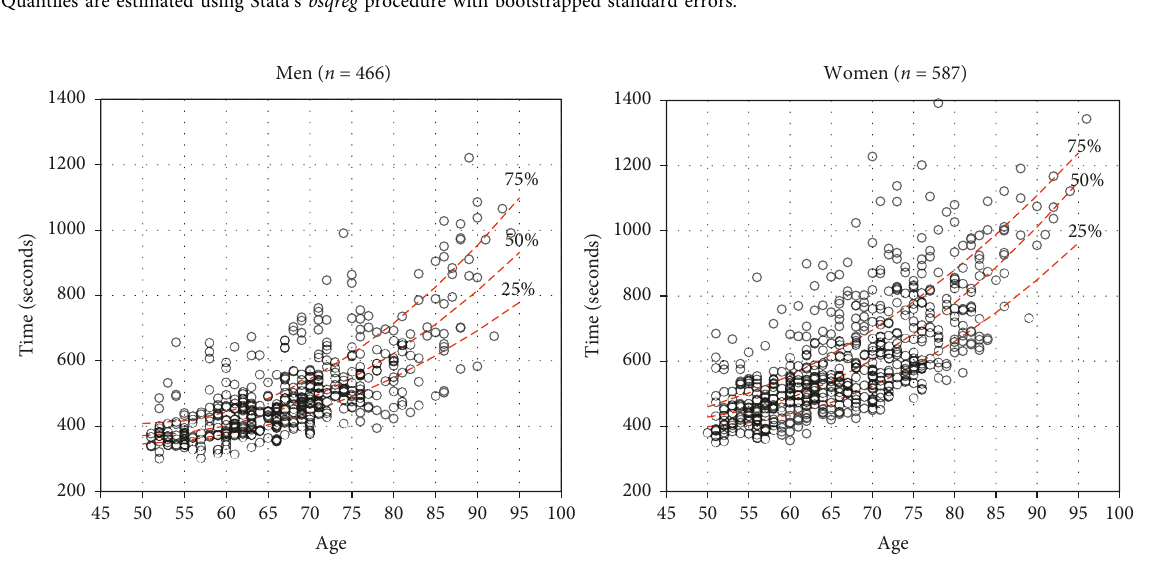
Figure 2: Quantiles for fitted quadratic model. Table 6: Predicted times for selected ages using quadratic model.